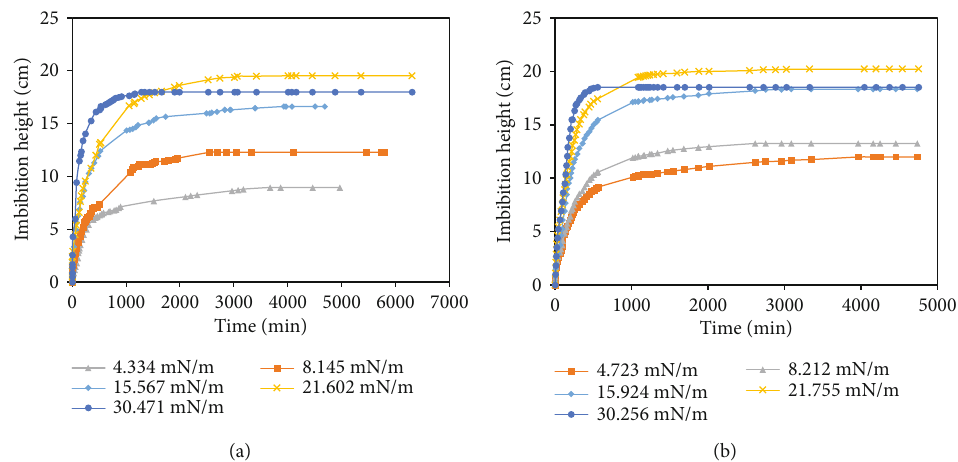
Figure 4: Change of imbibition height with time under di ff erent interfacial tensions. (a) With a salinity of 25000 mg/L. (b) With a salinity of 70000mg/L. Table 2: Results of imbibition experiments of rock samples in Group B. Salinity